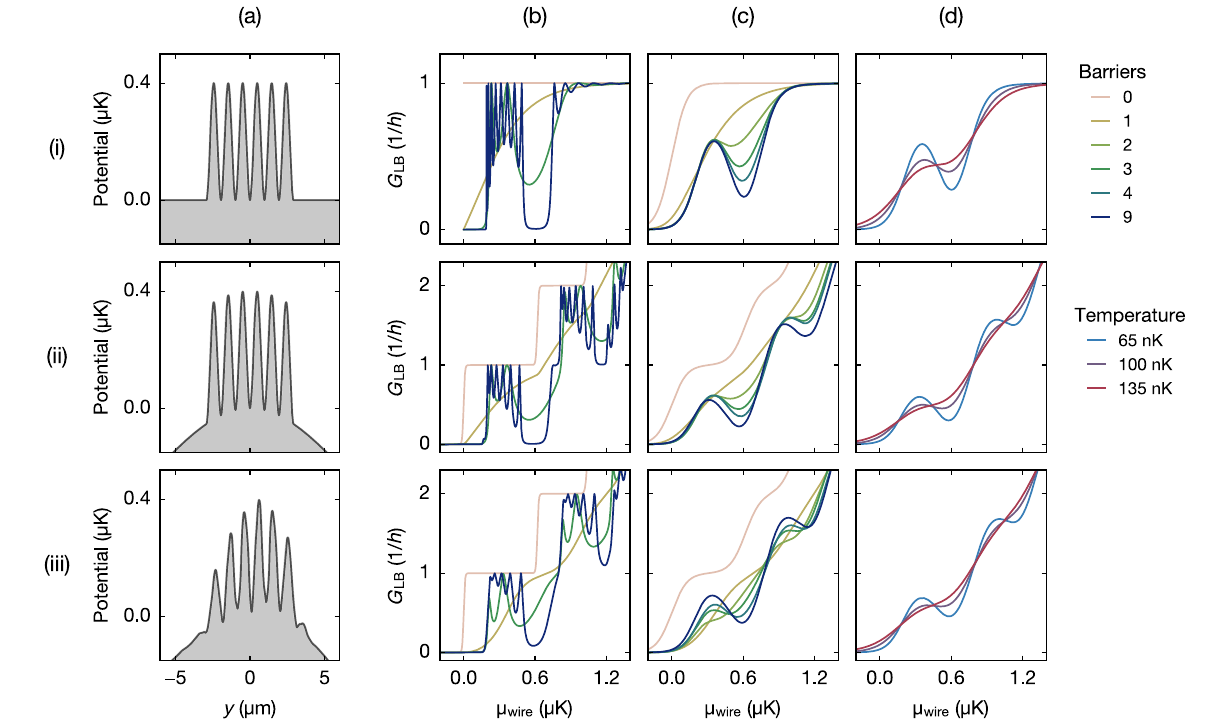
FIG. 7. Effect of the lattice potential on conductance, obtained from noninteracting Landauer-Büttiker theory. Results for (i) an ideal one-dimensional lattice potential on a flat background, (ii) an ideal lattice in the quasi-one-dimensional potential created by the quantum wire, and (iii) a real lattice in the effective potential of the quantum wire. Column (a): Effective potential of the lowest transverse mode. Column (b): Conductance G versus local chemical potential in the wire μ for different numbers of barriers N at temperature T ¼ 0 LB wire and infinitesimal bias Δ μ . Column (c): identical with T ¼ 60 nK and Δ μ ¼ 100 nK. Column (d): Conductance G versus chemical LB potential μ for N ¼ 6 barriers, Δ μ ¼ 100 nK, and different temperatures T wire